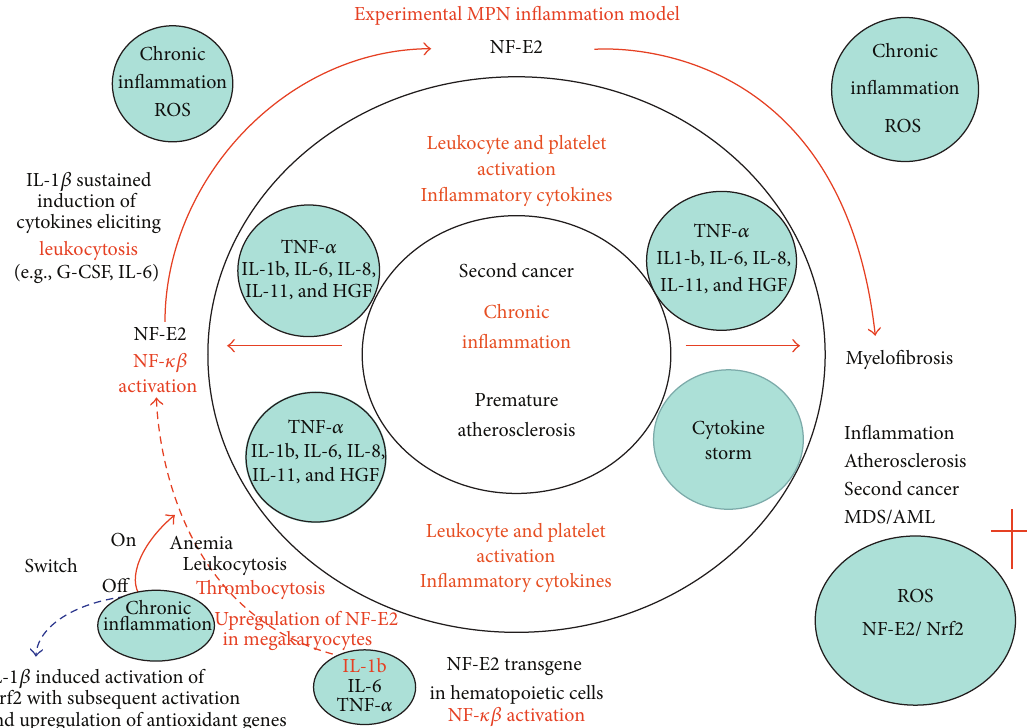
Figure 1: Sustained NF-E2 expression likely elicits a pronounced oxidative stress milieu with excessive ROS giving rise to myeloid expansion with leukocytosis and excessive thrombocytosis and inflammation-mediated in vivo activation of leukocytes and platelets, thereby further promoting a sustained, self-perpetuating release of inflammatory products. In this vicious circle, an oxidative stress burden with NF-E2 domination over Nrf2 promotes ROS accumulation and megakaryocytic differentiation. Increasing oxidative stress-induced DNA damage of hematopoietic stem cells (HSCs) elicits genomic instability and clonal MPN evolution with accumulation of mutations ultimately terminating in myelofibrotic and leukemic transformation. A relative deficiency of Nrf2 may also result in expansion of the HSC and progenitor cell compartment and ultimately migration of HSCs from their stem cell niches into the circulation (“leaving the burning nest”) to seed in the spleen and liver (myelofibrosis with myeloid metaplasia). The vicious circle may be locked by early intervention with interferon-alpha2 (stopping the fuel to the fire) in combination with a JAK1-2 inhibitor (e.g., ruxolitinib) and a statin, the latter agents “cooling down the system” by their highly potent anti-inflammatory properties which may actually be enhanced (synergism) when being administered simultaneously. With permission from Leukemia Research